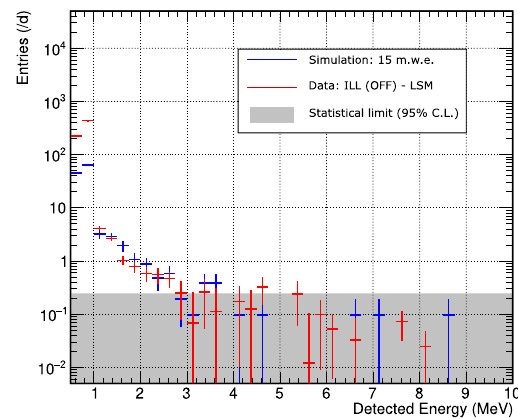
Fig. 8 Left: comparison between the observed 3 He energy spectra of the cosmogenic neutron background at the ILL-H7 site after 40.7 days of data taking (red) and its corresponding simulations (blue). Note that the red histogram has been obtained by subtracting the LSM data in order to remove the internal alpha background contamination. Right: comparisonbetweentheobserved 3 Heenergyspectraofthereactogenic neutron background at the ILL-H7 site after 46.3 days of data taking with an averaged reactor power of 42 MW (red) and its correspond- ing simulations (blue). Note that the red histogram has been obtained